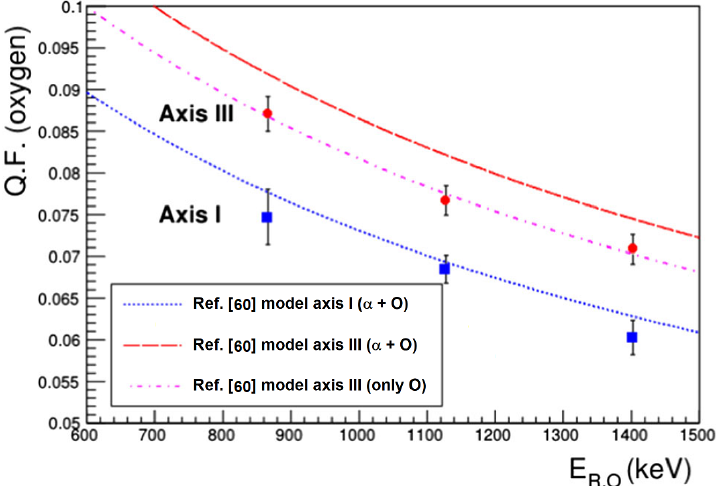
Figure 8. Quenching factors measured with a ZnWO 4 detector in Ref. [12] for oxygen nuclear recoils along the crystal axes I and III as a function of the expected recoil energies E R , O . The models for the considered crystal axes obtained by fitting the α ’s and oxygen recoil (O) data following the prescription of Ref. [60] are also reported. Reprinted with permission from [12]. Copyright 2020 Springer